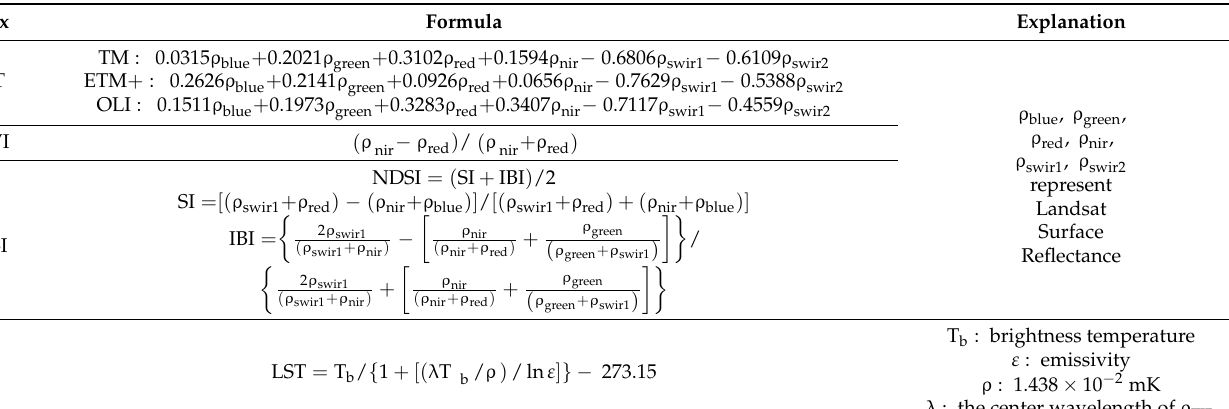
Table 2. Indexes of Ecological